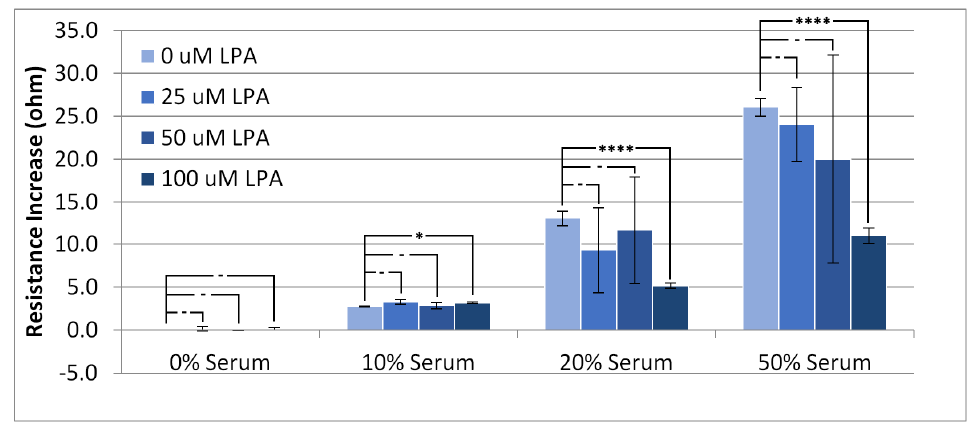
Figure 4. Resistance increase in the TSM signal on addition of PBS/serum samples with LPA. Statistical significance using t -test shown by asterisks: (-) no significant difference, (*) 90% confidence, (****) 99% confidence.